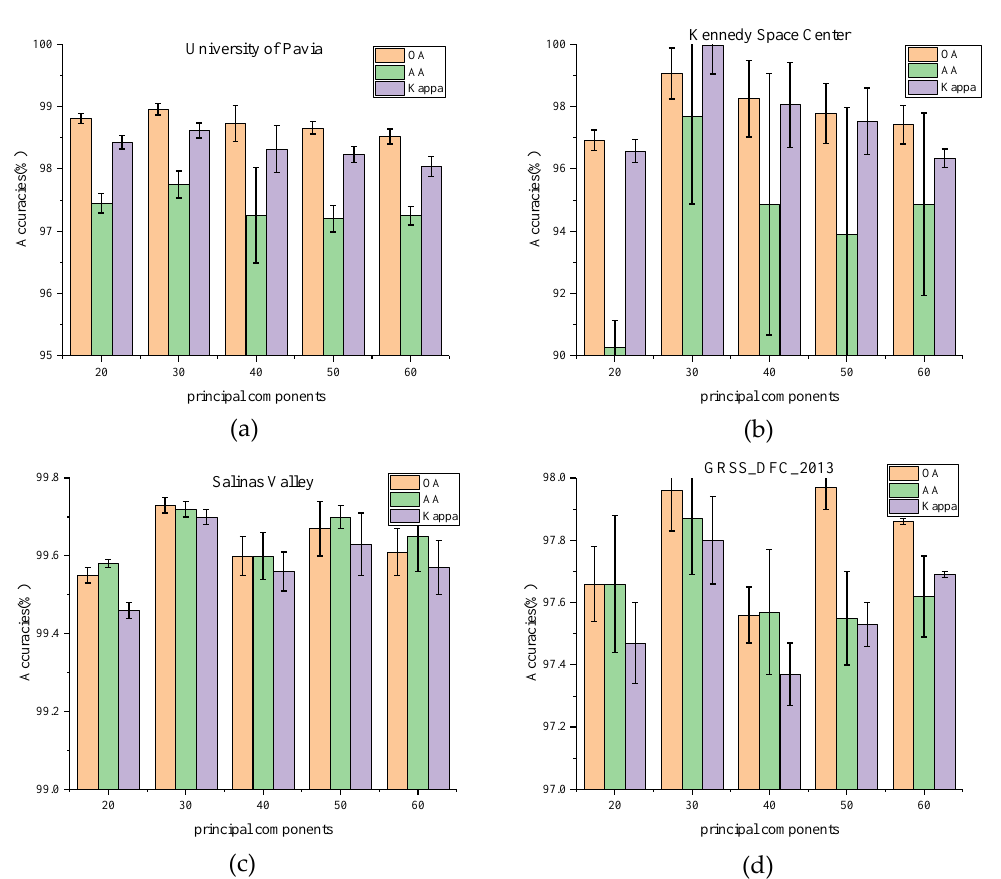
Figure 5. OA, AA, and Kappa accuracies with different principal components on four datasets. ( a ) Effect of principal components on University of Pavia dataset, ( b ) Effect of principal components on Kennedy Space Center, ( c ) Effect of principal components on Salinas Valley dataset, ( d ) Effect of principal components on GRSS_DFC_2013 dataset.